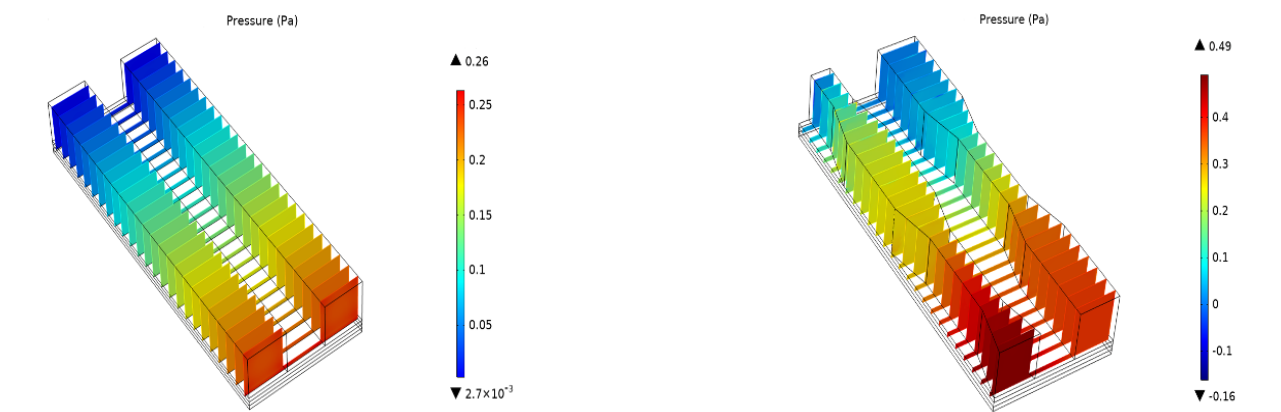
Figure 5. Pressure profile in conventional channel and novel channel.